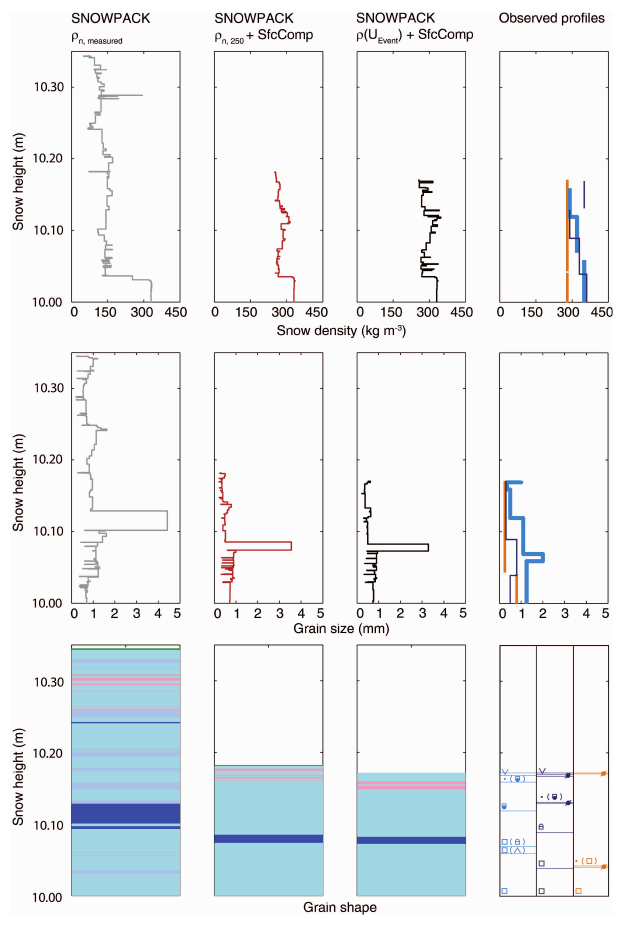
Fig. 8. Snow profile on 10 December 2008 as simulated with SNOWPACK using, from left to right, either measured new snow density as input (“ ρ n , measured ”), or an initial snow density of 250kgm − 3 (“ ρ n , 250 + SfcComp”), or the event-driven mechanism (“ ρ(U event ) + SfcComp”), the latter two with additional surface compaction due to wind. For comparison, three observed snow pro- files taken in the vicinity of Concordia research station around this date are shown in the rightmost column. Note that the colours cor- respond to those used in Fig. 7. The observation in light blue was thus done at Concordia research station close to the sites from which observations were taken as initialization to SNOWPACK. The other observations were done at two locations 6 and 7km NW from the re- search station (dark blue and orange, respectively). The snow height of the observed profile is adjusted to the top of the event-driven simulation with surface compaction (“ ρ (U event ) + SfcComp”) but note that the density of the topmost centimetre was not recorded in the field. Top panels show snow density (kgm − 3 ), middle pan- els grain size (mm), and bottom panels colour coded grain shapes: precipitation particles PP = lime, rounded grains RG = light pink, faceted crystals FC = light blue, depth hoar = blue, surface hoar SH = fuchsia. Additionally, rounding faceted particles FCxr are de- scribed by a mixture of light blue and light pink. Symbols represent the observed grain shapes. Both colour code and symbols follow Fierz et al.